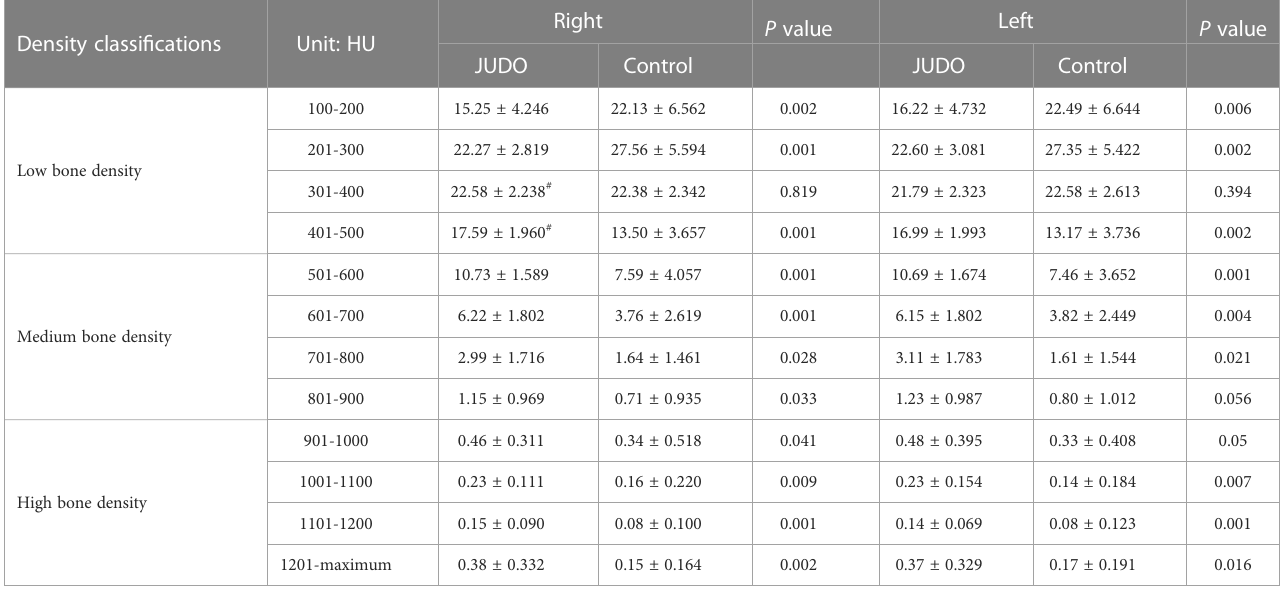
TABLE 4 Comparison of the bone tissue volume individuals in the distal femur subchondral bone between the groups (%).